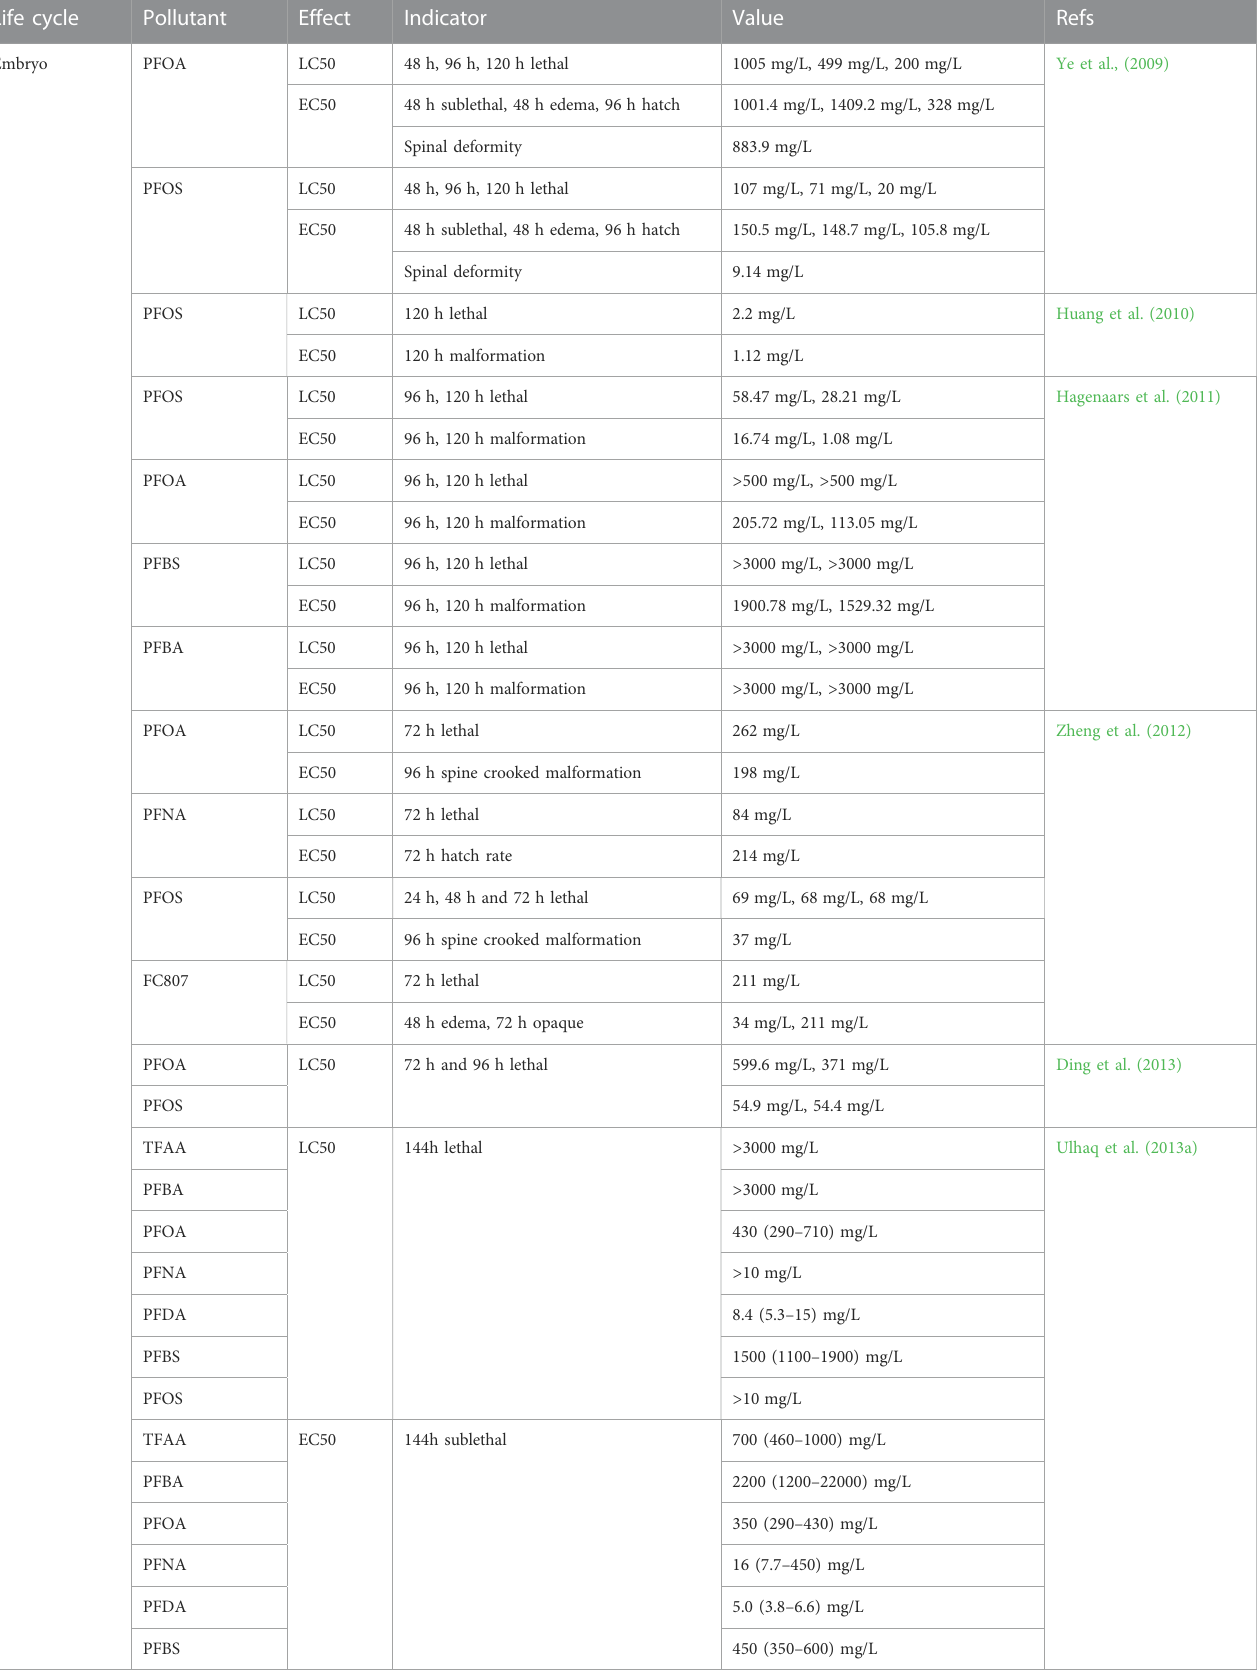
TABLE 1 EC50/LC50 values of target PFASs and some substitutes on zebra fi sh. Life